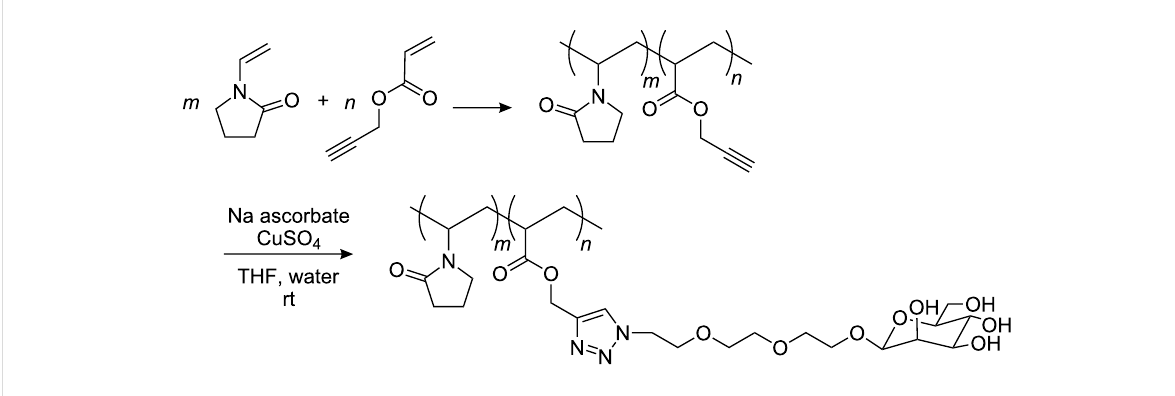
Figure 2: Preparation of poly(propargyl-co- N -vinyl pyrrolidone) and subsequent addition of the mannose derivative by click chemistry.